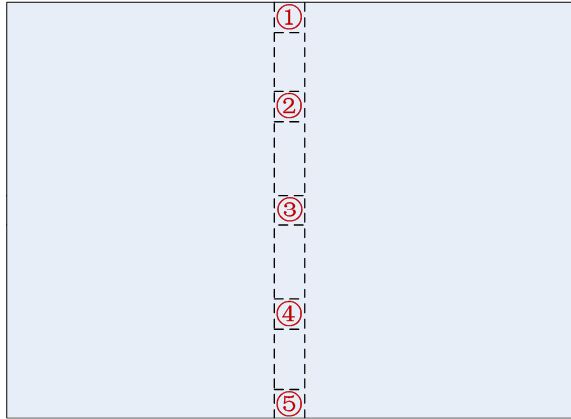
Figure 15. Sampling plan. Table 5. Non-metallic inclusions in the billet after improvement.